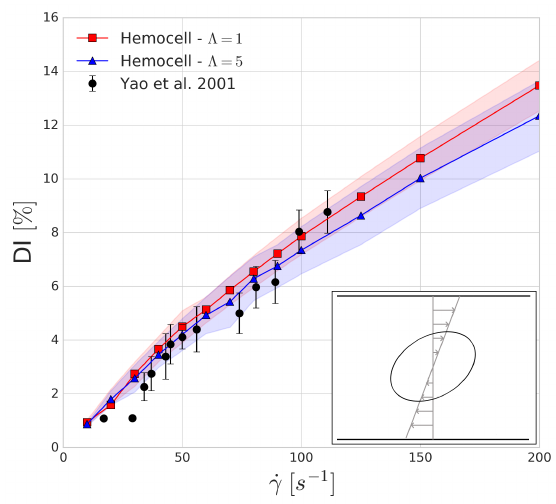
Figure 3. Wheeler test done with and without viscosity contrast and compared to experimental values reported by Yao et al. [46]. The shaded regions represent the uncertainty in the simulation results arising from the mesh